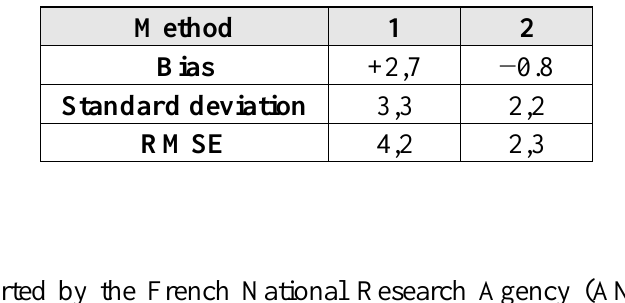
Table 3. Analysis of differences between estimated and measured soil moisture. The test with cells of 500 × 500 pixels use the land surface condition (in each cell, there are as many moisture values as of land surface